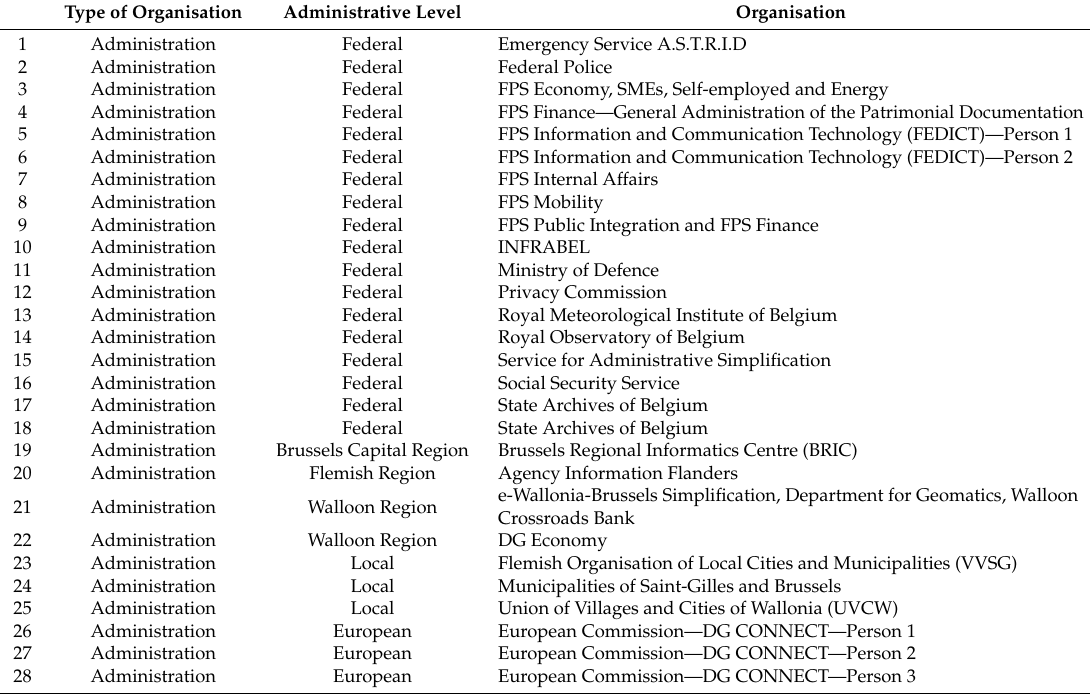
Table 2. Organisations interviewed between August 2016 and May 2017 (listed